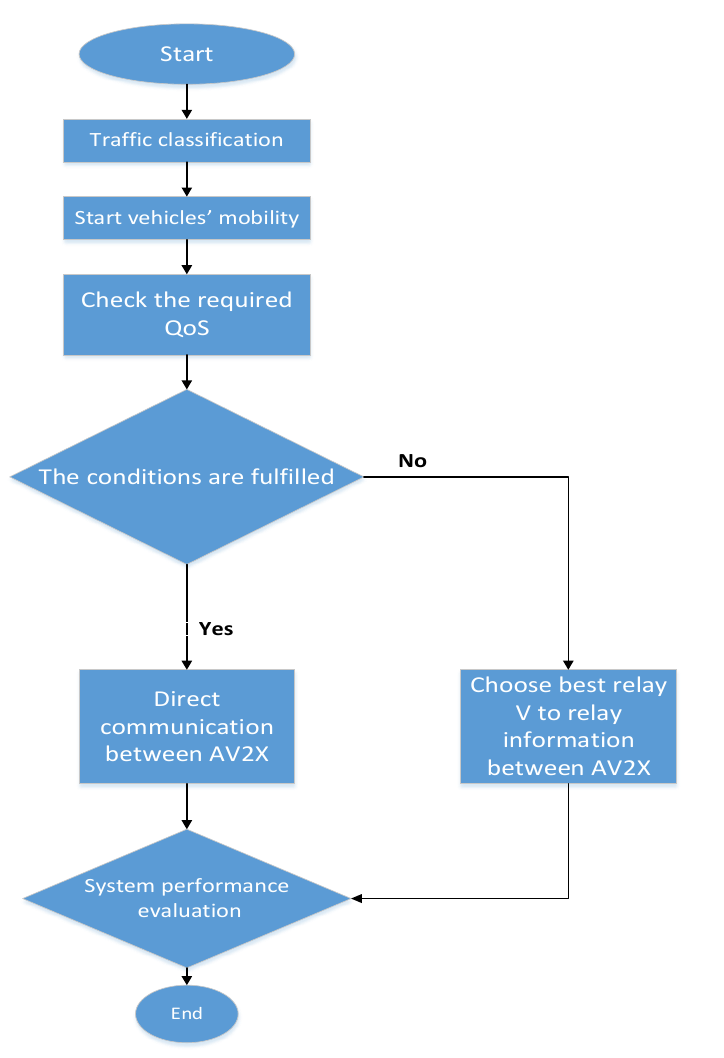
Figure 1. Flow chart for the proposed adaptive model.